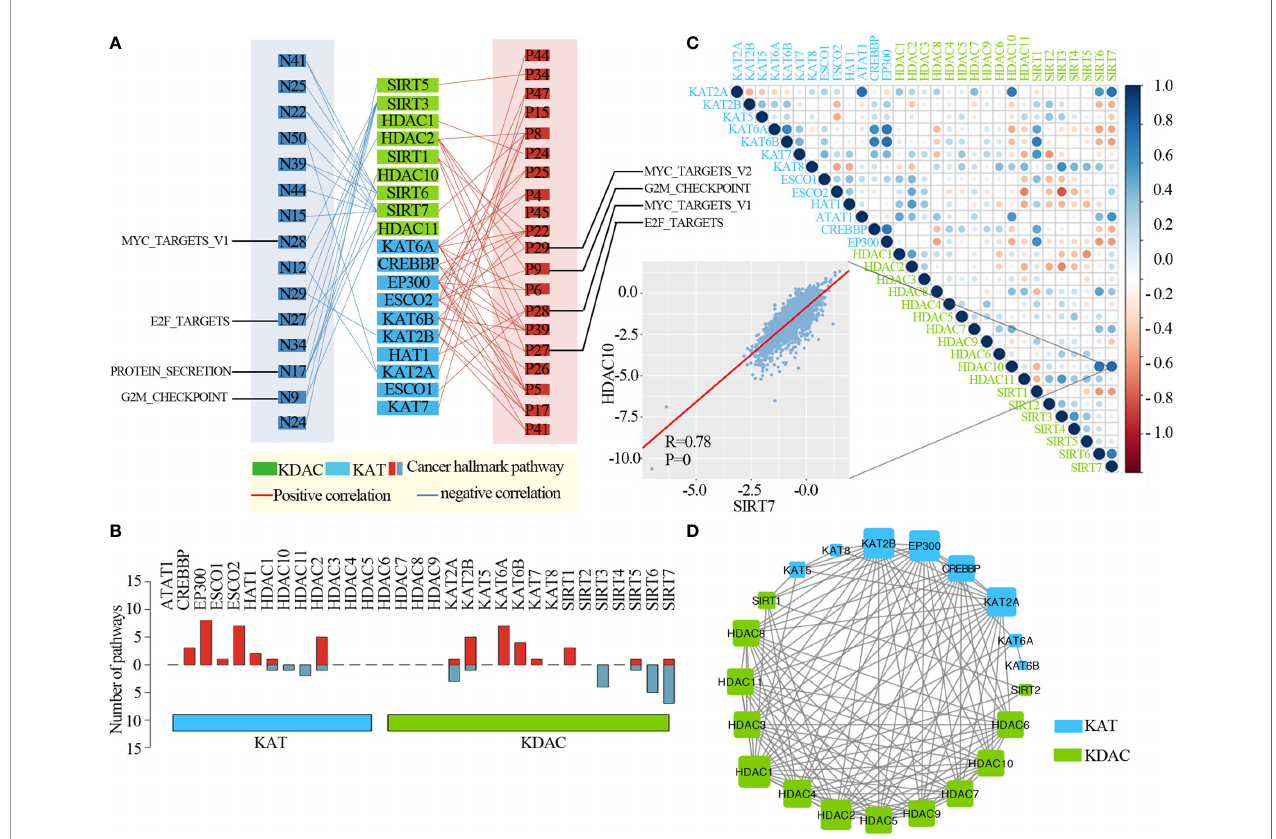
FIGURE 4 | Lysine acetylation regulators are associated with the activation and inhibition of cancer pathways. (A) Network diagram demonstrating the correlation between lysine acetylation regulators and cancer pathways. Red represents a positive correlation, and blue represents a negative correlation. The size of the nodes corresponds to the number of links. (B) The number of pathways is correlated with individual lysine acetylation regulators. The upper panel is for positively correlated pathways, and the bottom panel is for negatively correlated pathways. (C) Correlation among the expression of lysine acetylation regulators. The scatter plot shows the correlation between HDAC10 and SIRT7. (D) The protein-protein interactions among lysine acetylation